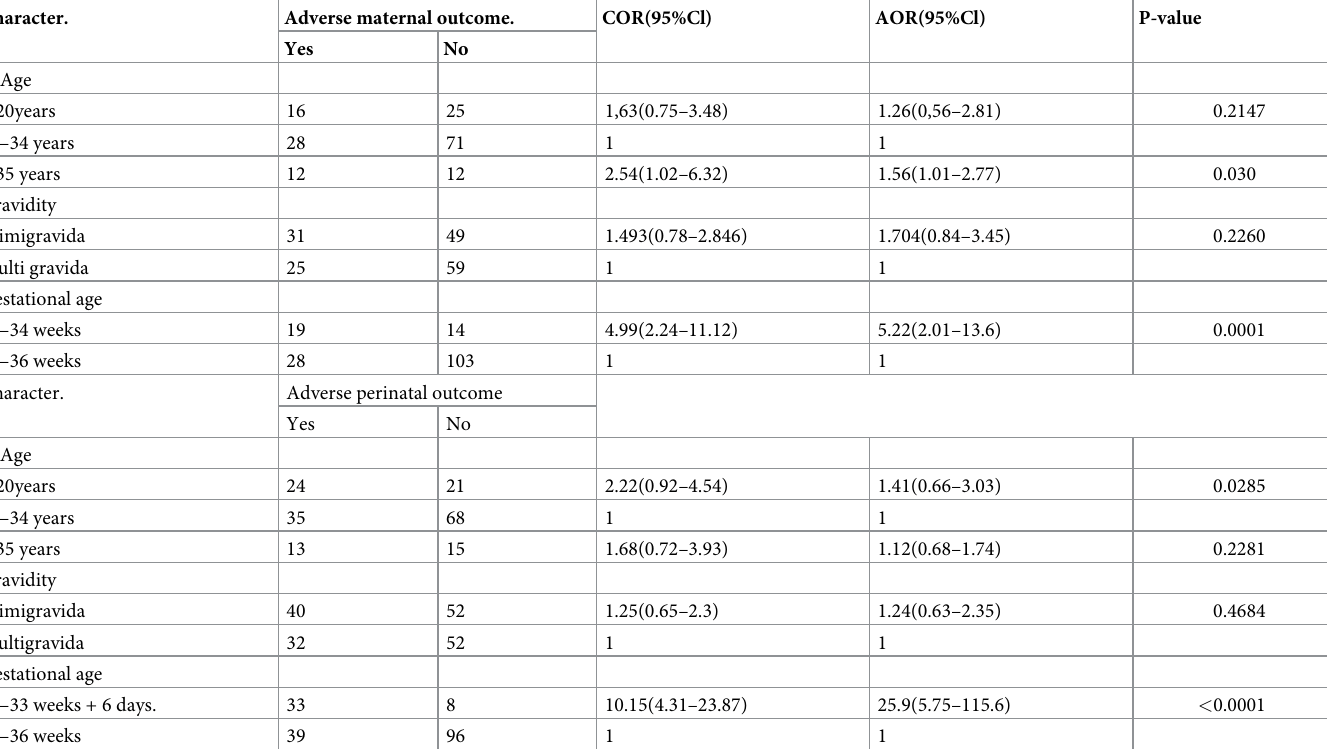
Table 3. Factors associated with adverse maternal and perinatal outcomes during expectant management of preeclampsia without severe feature at SPHMMC, 2018. Character. Adverse maternal